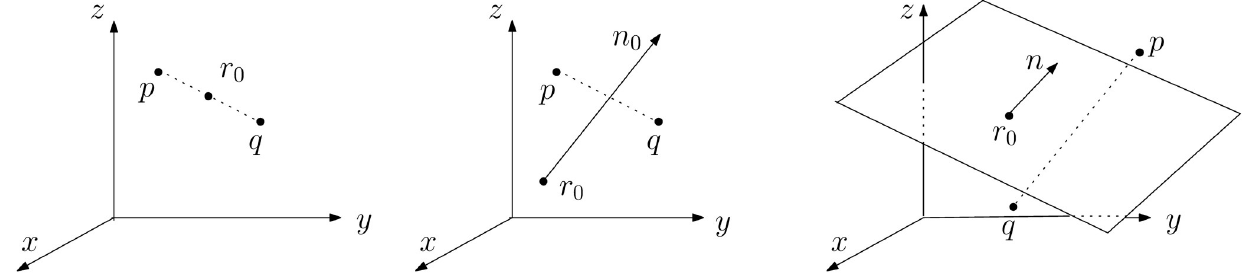
Fig 1. Point, line and plane reflections between 3D points p and q